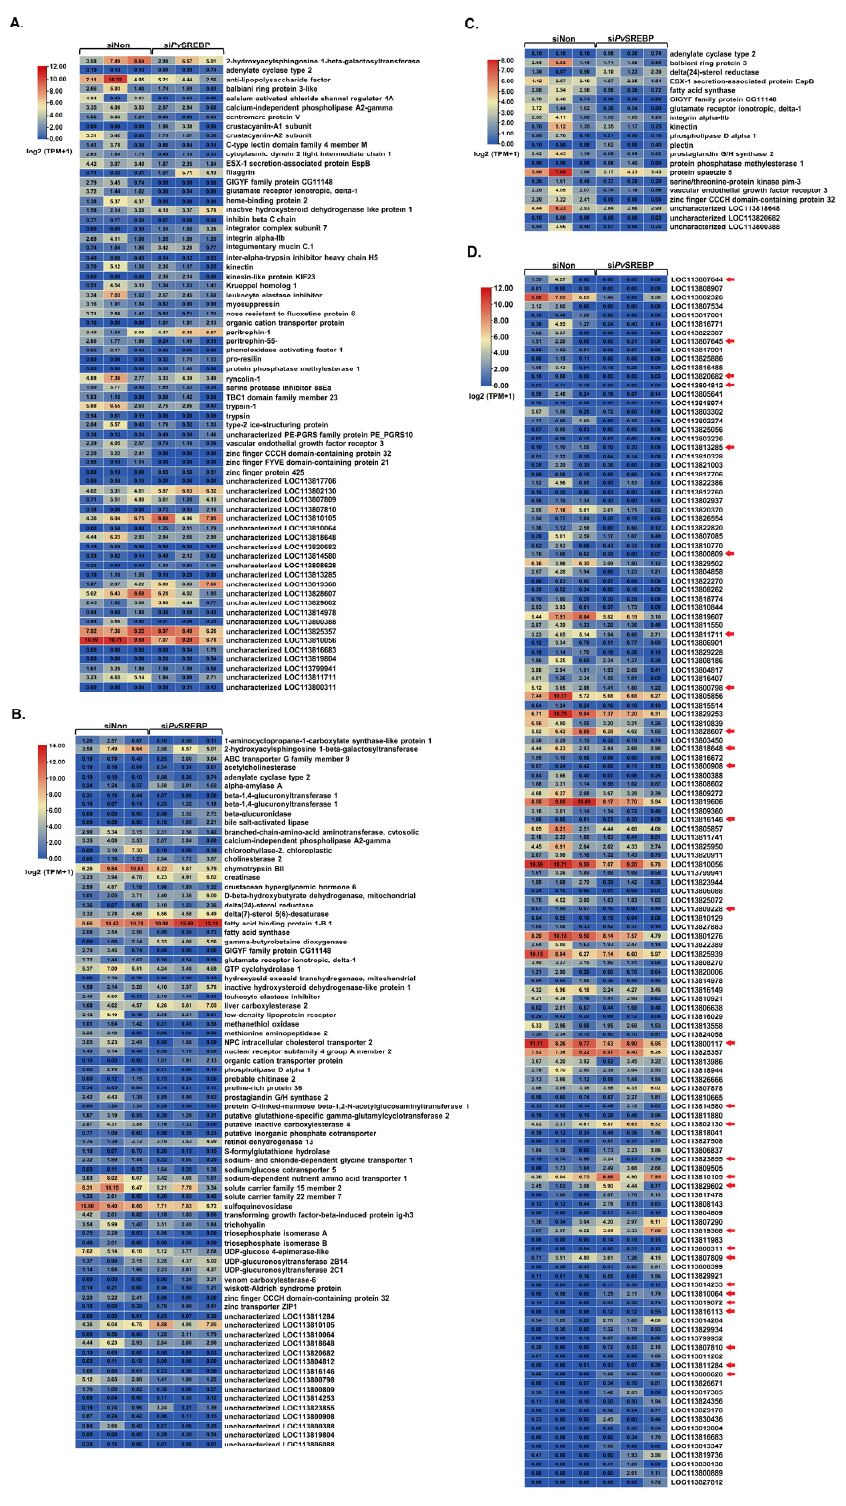
Figure 4. Expression and distribution of important DEGs. Heat maps showing DEGs related to ( A ) immune response, ( B ) metabolism, ( C ) cellular signaling pathways, and ( D ) DEGs with unannotated functions. The red arrows point to genes with putatively annotated functions in the NR database. Three independent samples were analyzed per treatment (siNon and si Pv SREBP). Color legend is on a log2 (TPM + 1) scale.